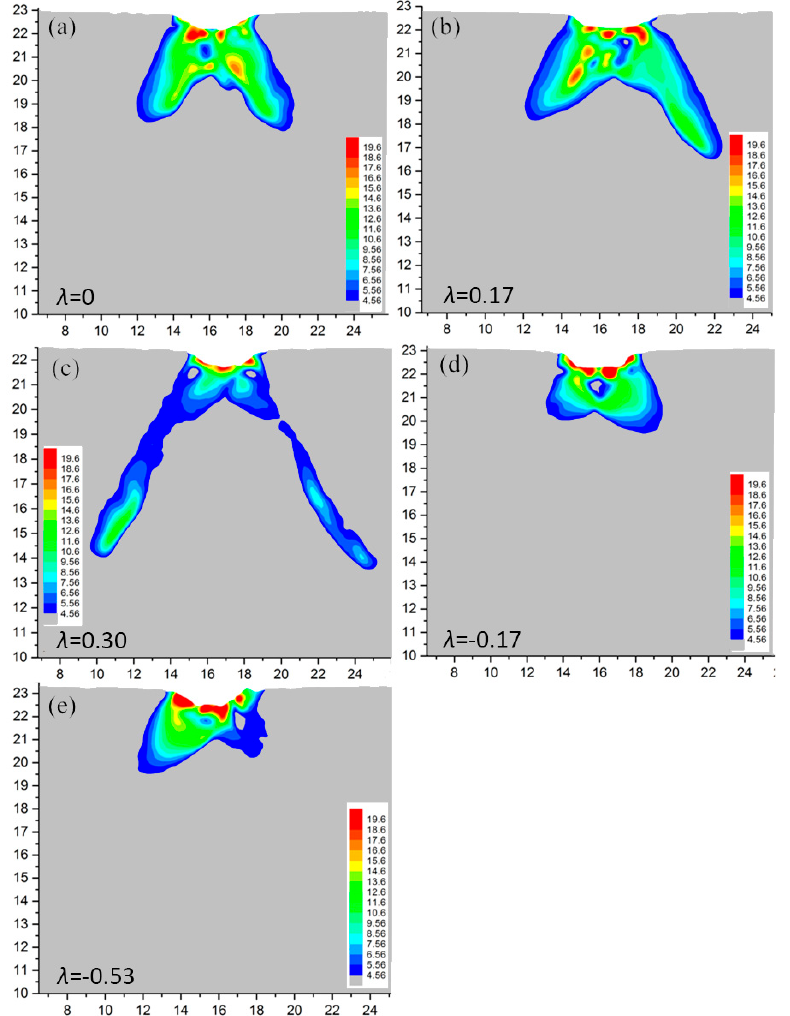
Figure 14. Indentation plastic zone with different residual stresses: ( a ) λ = 0; ( b ) λ = 0.17; ( c ) λ = 0.30; ( d ) λ = − 0.17; ( e ) λ = − 0.53.